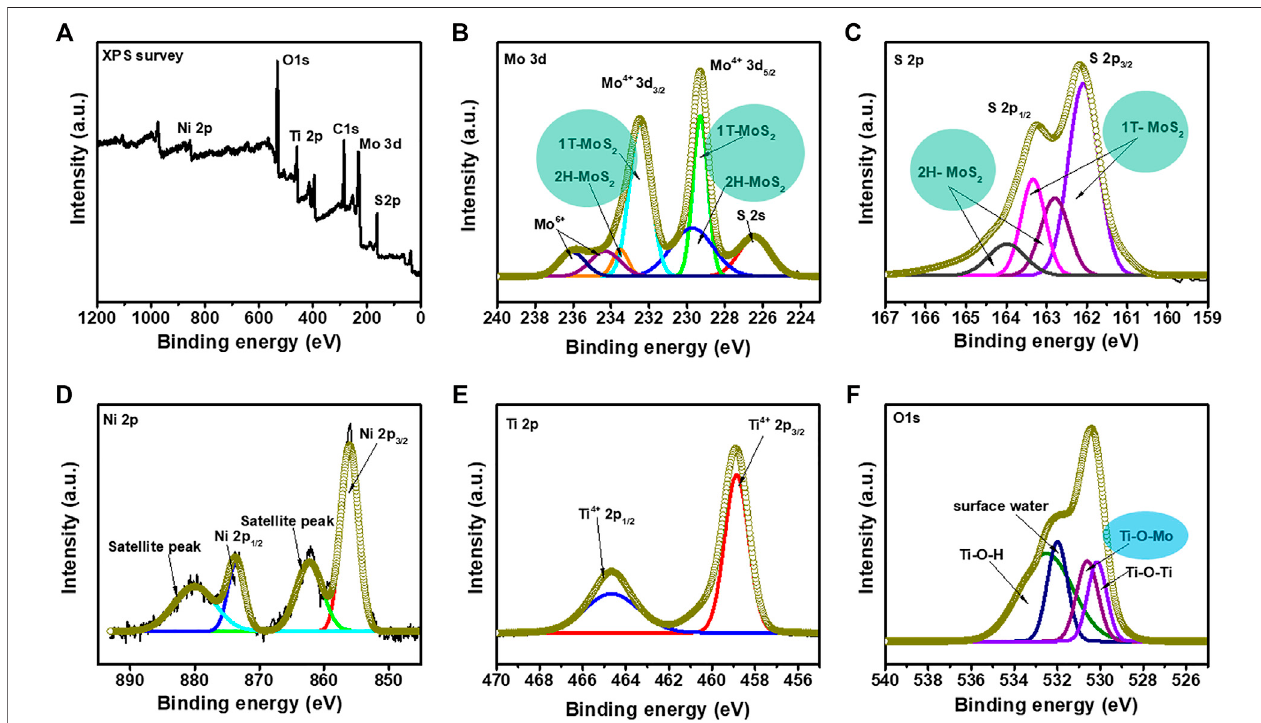
FIGURE 4 | X-ray photoelectron spectra of NMS-2 (A) Survey spectrum. Deconvoluted spectra of (B) Mo 3d band showing characteristic peaks of the 1T and 2H MoS 2 phases (C) S 2p band showing characteristic peaks of the 1T and 2H phases of MoS 2 , (D) Ni 2p band (E) Ti 2p band, and (F) O 1s band con fi rming strong interaction between the NiTiO 3 nano fi bers and MoS 2 constituents in the hybrid structure.